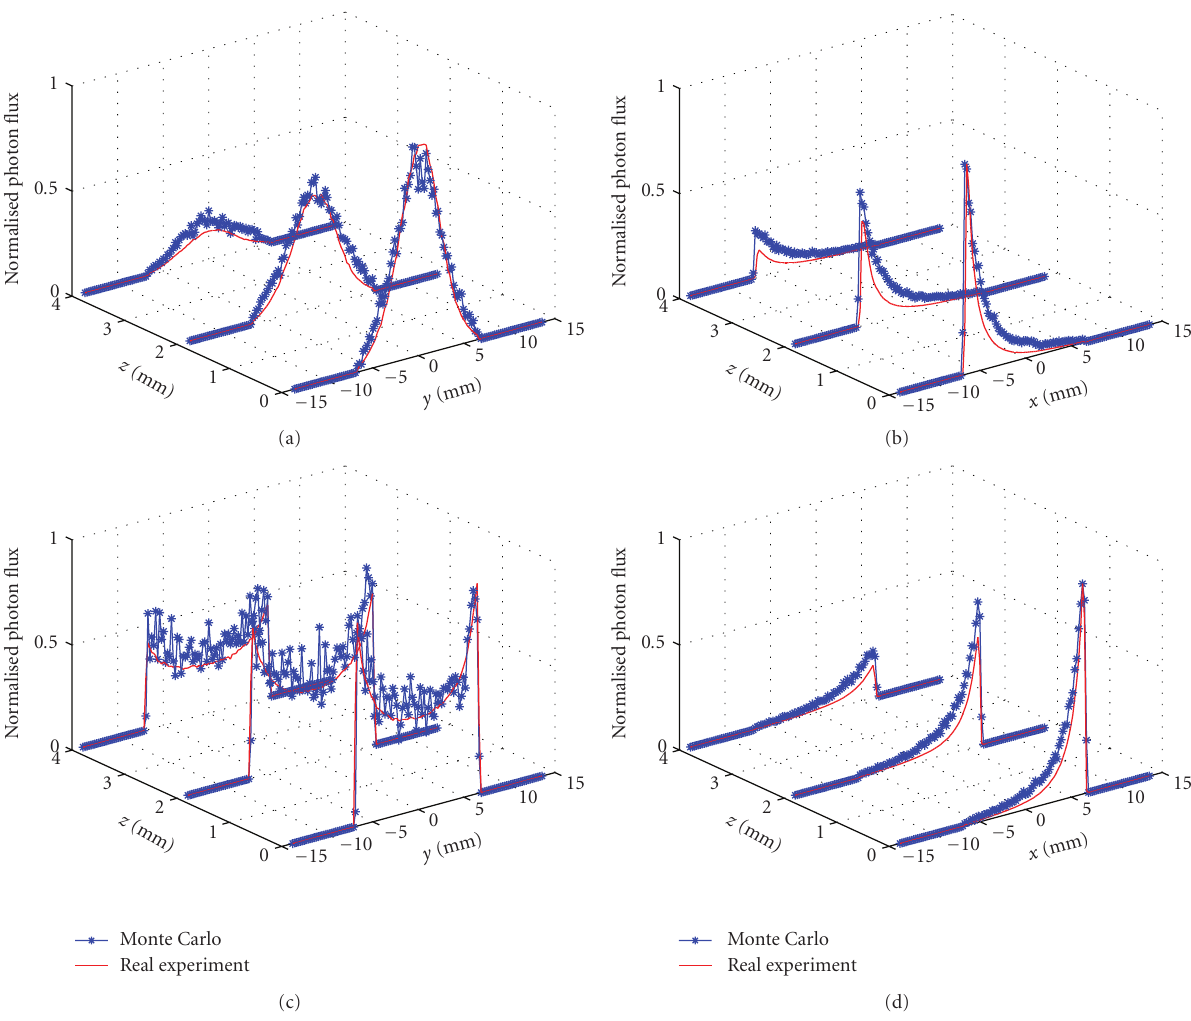
Figure 6: Comparison of MC simulation and real experiment at the detector position: z d = 0.0, 2.0, 4.0 mm. (a)–(d) front-, left-, back- and right-perspective.